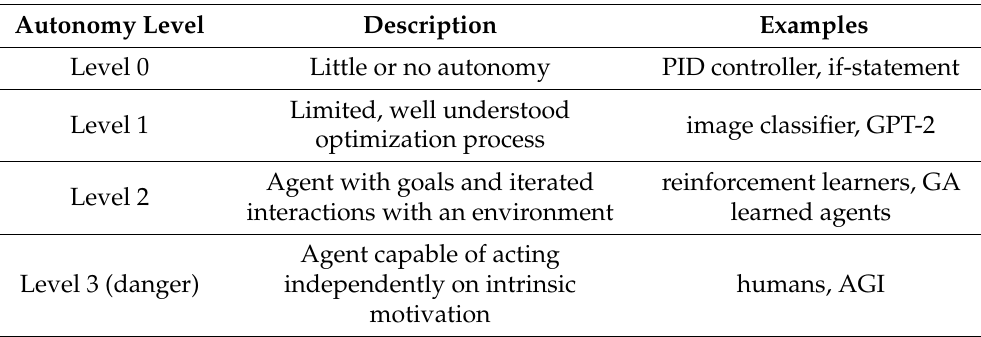
Table 5. AI autonomy levels with examples. Reinforcement learning agents and GA are considered highly autonomous due to their superhuman performance in Atari games [52] and robotic control [53]. The properties that allow for this performance also cause them to have high scores in the AI risk factors explained in this section.